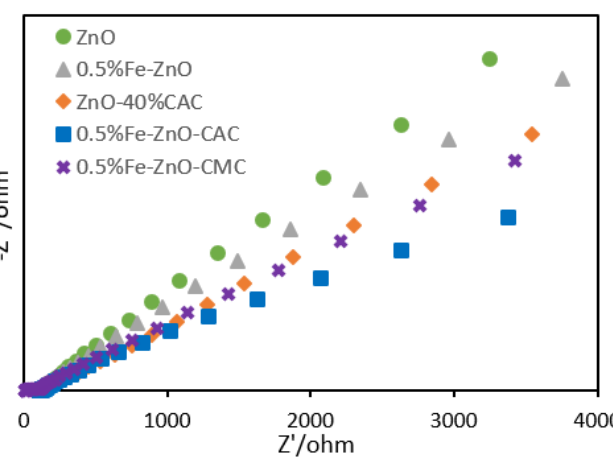
Figure 6. Electrochemical impedance spectroscopy measurement of the 0.5%Fe-ZnO-40%CAC and 0.5%Fe-ZnO-40%CMC ( [Na 2 SO 4 ] = 1 M).